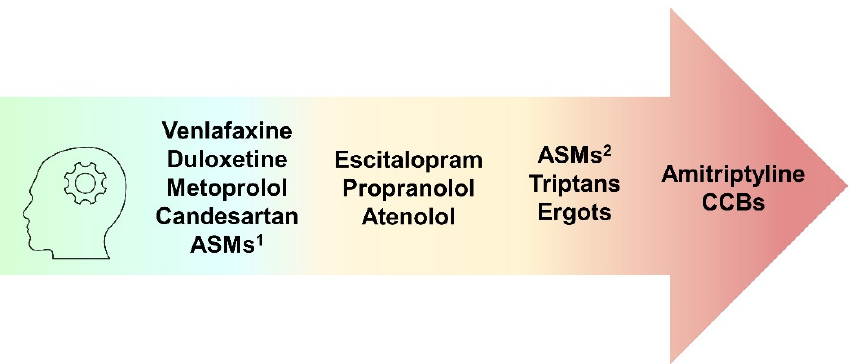
Figure 2. Cognitive effects of migraine treatments. In the green section: compounds with positive effects on cognition; in the yellow section: compounds with mild negative effects; in the orange–red section: compounds with the worst impact on cognitive performances. Abbreviations: ASMs = anti- seizure medications, type 1: lamotrigine, levetiracetam, type 2: valproic acid, topiramate, gabapentin, pregabalin, zonisamide, CCBs = calcium channel blockers.